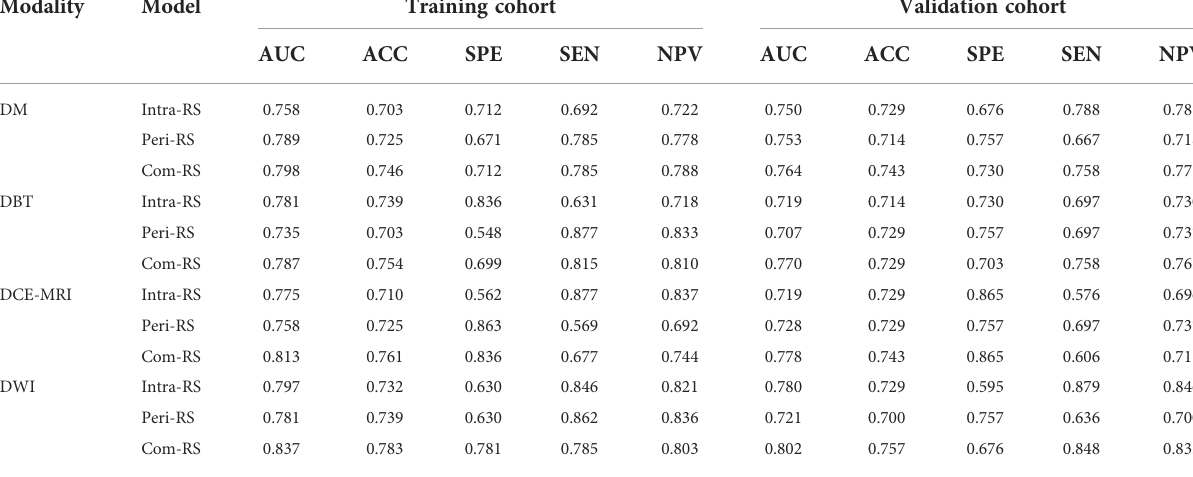
TABLE 2 Prediction performance of RSs derived from intra-, peri- and combined tumoral regions.